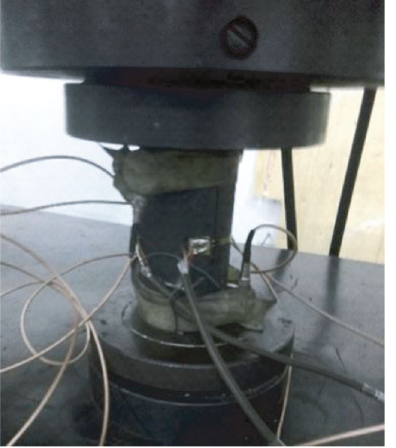
Figure 5: Testing procedure.